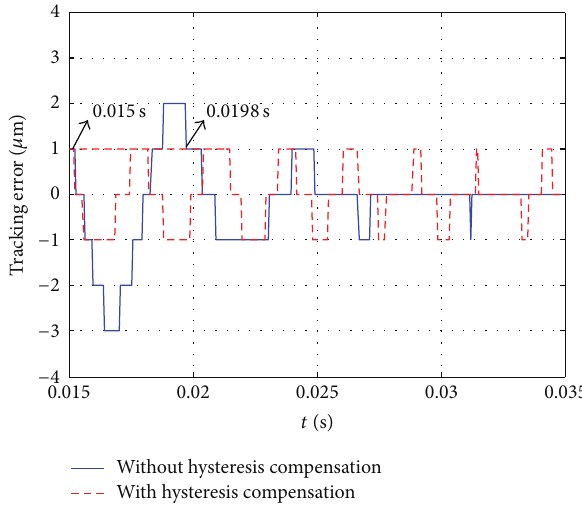
Figure 12: Comparison of the position tracking error during the constant velocity segment.